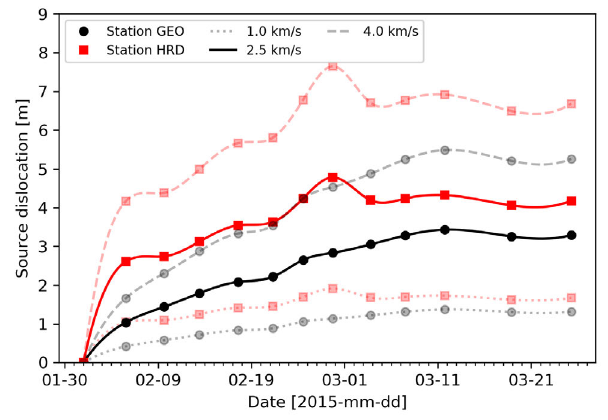
Figure 7: Calculated source displacements for Family 1 at stations GEO (black) and HRD (red). Solid lines are estimates − 1 using v p of 2.5 km s with dotted lines indicating the lower − 1 − 1 (1 km s ) and upper (4 km s ) bounds of possible seismic